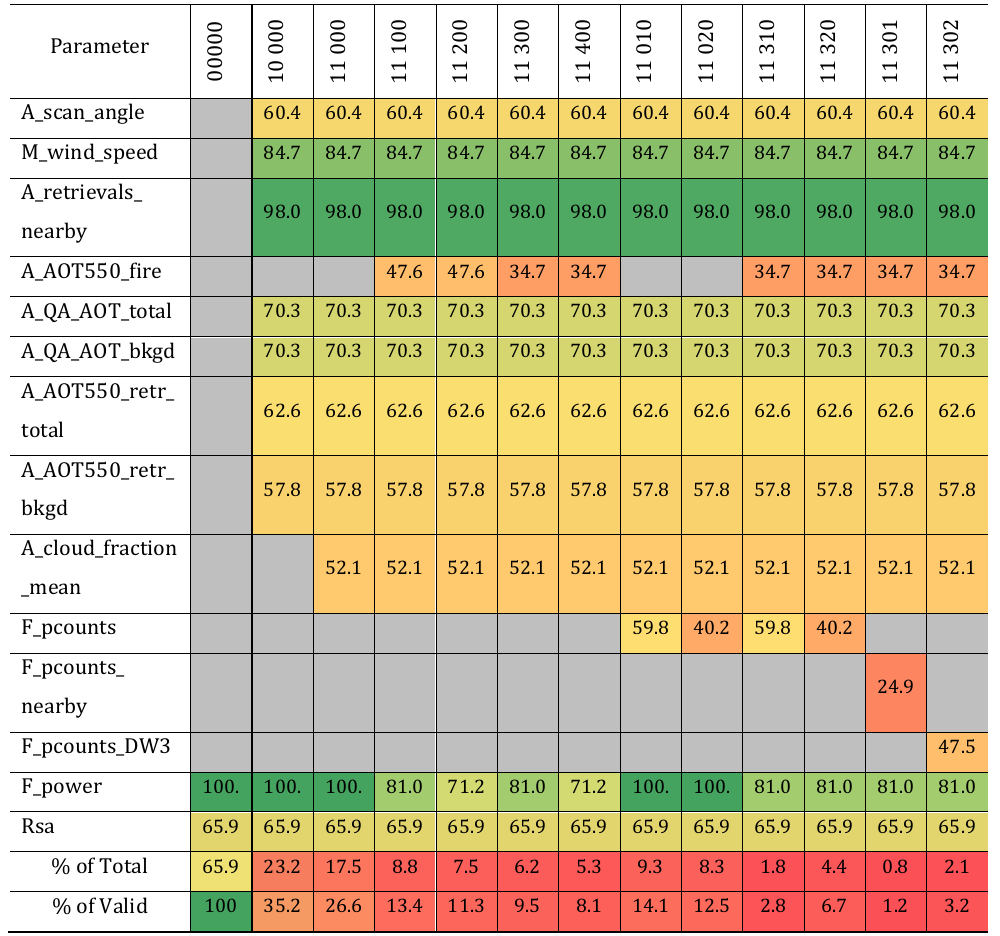
Table 3. Percentages of all available data that meet the threshold requirements in Table 2. These numbers were derived using the global coverage of MODIS-Aqua retrievals for the first day of each month in 2010. The number of retrievals over this data set totaled 43211, whereas the number of valid retrievals (where “F_power” and “Rsa” are both greater than zero, see setting 00000 in Table 2) totaled 28494. The last row (“% of Valid”) shows the overall percentages based on the 00000 setting, which gives an estimate using only valid data. Values are color-coded in different shades of red < 15%, 15% < orange < 50%, 50% < yellow < 70%, green > 70%.